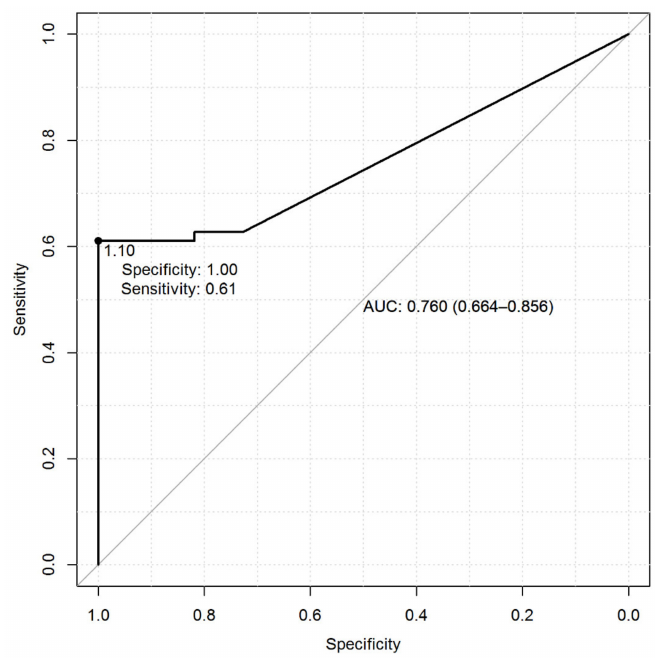
Figure 2. Receiver Operating Characteristic (ROC) curve calculated from SPARC / ACTB (Actin β ) promoter methylation ratio in normal lung distant from tumor (NLDT) paired with NSCLCs and assessed by QMSP. The ROC curve shows the sensitivity (y axis) and specificity (x axis), based on the comparison between tumor (ADC and SqCC) and NLDT (Normal Lung Distant from Tumor) groups (Mann-Whitney p -value, p < 0.001).